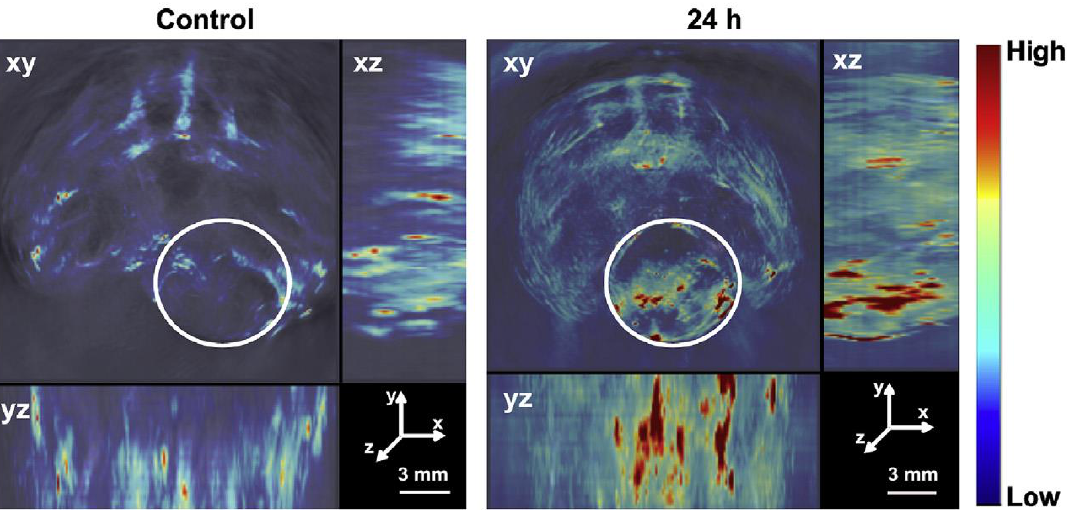
Figure 2. Photo-acoustic images showing tumor accumulation and photothermal efficiency of DPS- NP/PDA after 24 h of nanoparticles administration in tumor-bearing mice. Reproduced with permission from reference [143].